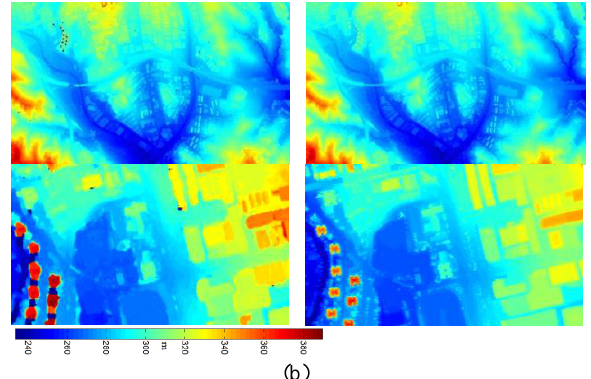
Figure 8. Point clouds and DSM from LiDAR and stereo images of the Terrassa dataset. (a). Point clouds comparison. (b) DSM comparison: left column, DSM computed by RSP; right column, DSM from LiDAR data.